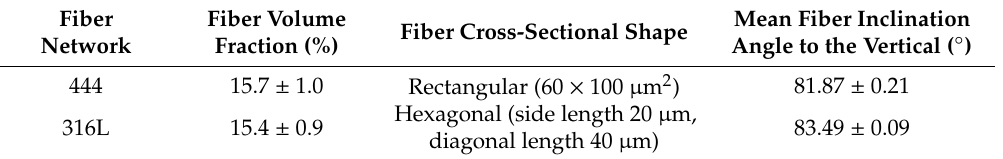
Table 2. Fiber volume fractions, cross-sectional shapes and mean fiber inclination angles (angle between the fiber axis and the through-thickness direction) for 444 and 316L networks